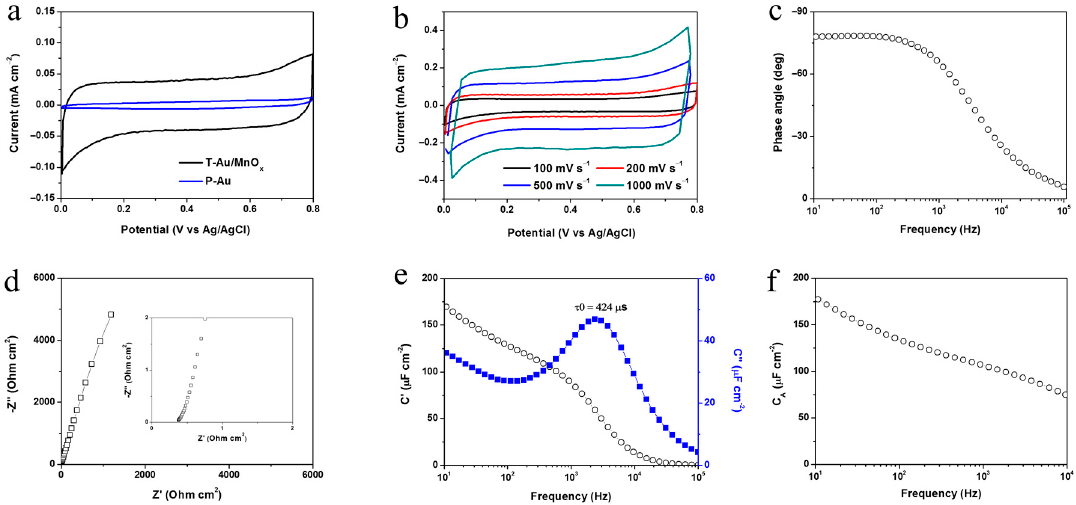
Figure 2. Three-electrode measurement: ( a ) CV comparison of P-Au and T-Au/MnO x at 100 mV s − 1 , ( b ) CV measurements of T-Au/MnO x at varying scan rates. Full cell measurement of on-chip HFSCs: ( c ) Phase angle versus frequency, ( d ) Nyquist plot, ( e ) Plots of the real or imaginary part of the specific capacitance as a function of frequency, ( f ) Areal specific capacitance versus frequency.